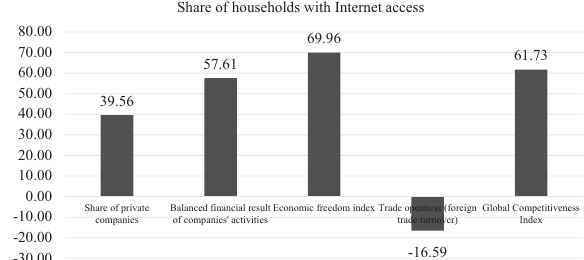
Fig. 1 Correlation between the manifestations of capitalism and the share of households with Internet access in Russia (%). Source: Calculated by the authors.